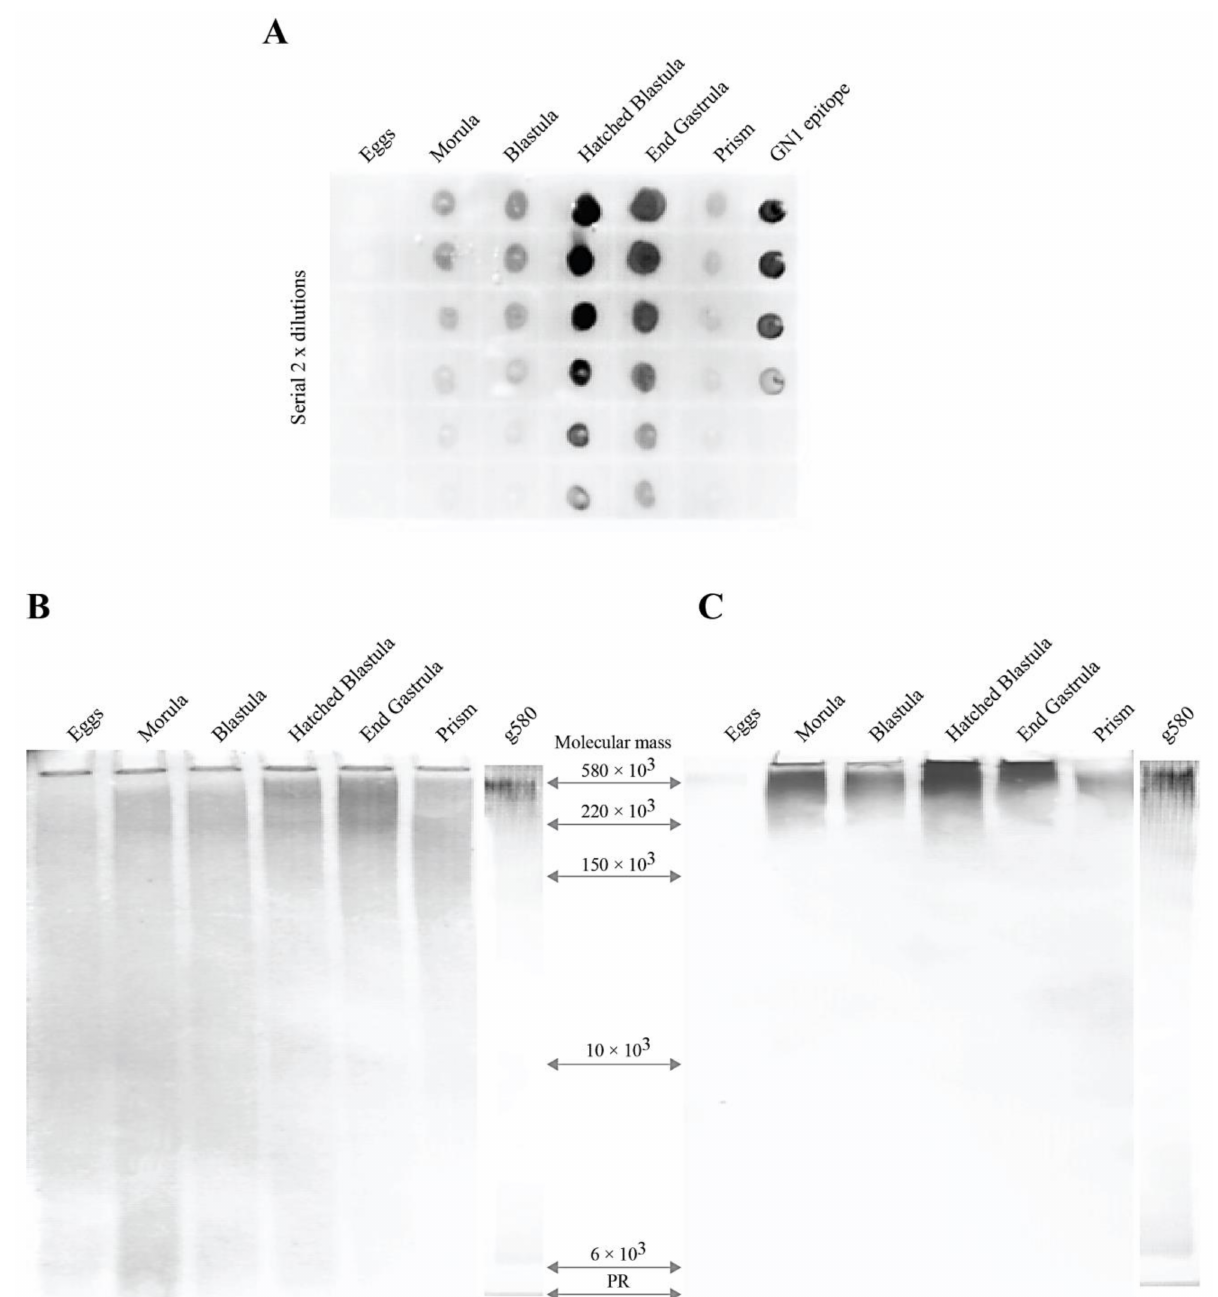
Figure 1. Expression of the GN1 epitope during L. pictus sea urchin development. ( A ) immunodot assay of total sea urchin glycans isolated from six developmental stages with the Block 2 monoclonal antibody. Then, 0.5 µ L of glycans of two-fold dilutions starting with the concentration of 1 µ g/ µ L water were spotted onto a DEAE-nitrocellulose paper. After brief drying DEAE-nitrocellulose was immunodecorated with the Block 2 monoclonal antibody and stained with anti-mouse peroxidase conjugated antibodies as described in Material and Methods. ( B ) polyacrylamide gel electrophoresis on 5–20% gradient gels of 25 µ g sea urchin total protein-free glycans prepared from six different developmental stages, and 2.5 µ g of immunopurified g580 sea urchin glycan from hatched blastula stage glycans were performed as described under Material and Methods. Gels were stained with Alcian blue for detecting acidic glycans. ( C ) immuno-detection of the GN1 epitope by the Block 2 monoclonal antibody in sea urchin glycans after gel electrophoresis as in ( A ), and electro-blotting. Glycosaminoglycans, heparin of M r = 11 × 10 3 D, chondroitin sulfate of M r = 20 × 10 3 and M r = 100 × 10 3 and hyaluronic acid of M r = 225 × 10 3 D, and sponge glyconectins g200 of M r = 200 × 10 3 D and g6 of M r = 6 × 10 3 were used as molecular weight